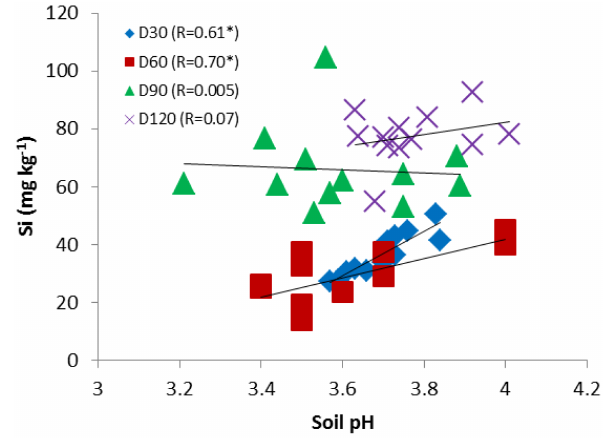
Figure 5. Relationship between exchangeable Al and soil pH ( ∗ p< 0 . 05).